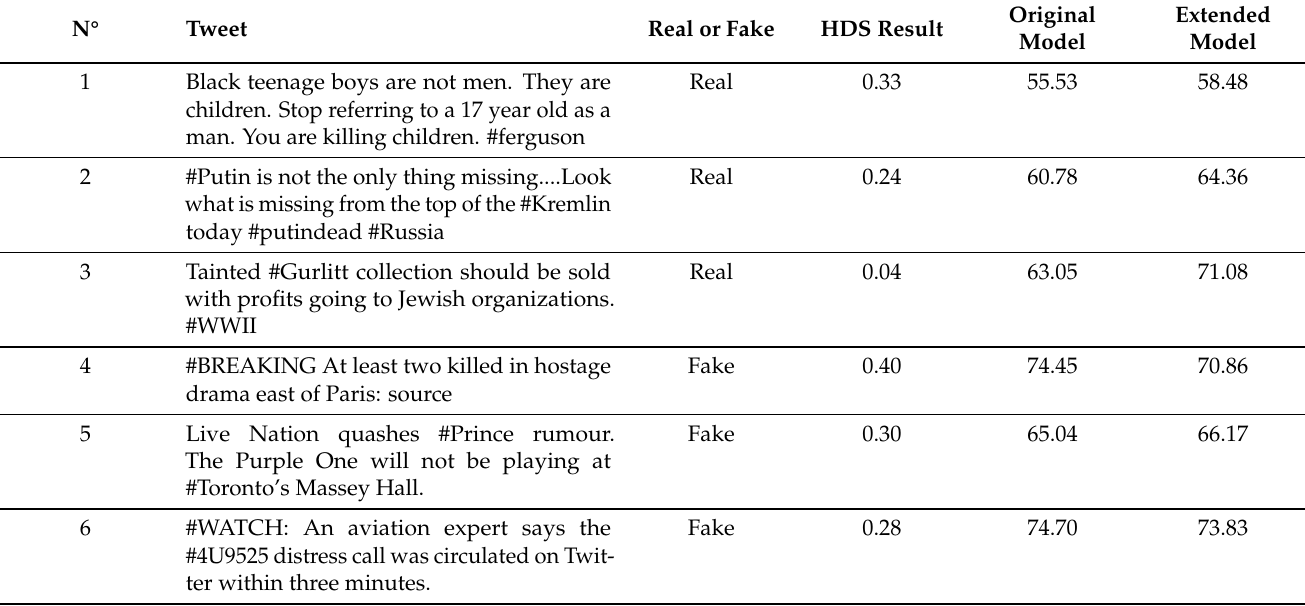
Table 5. Examples of HDS and credibility measures in tweets with hashtags.